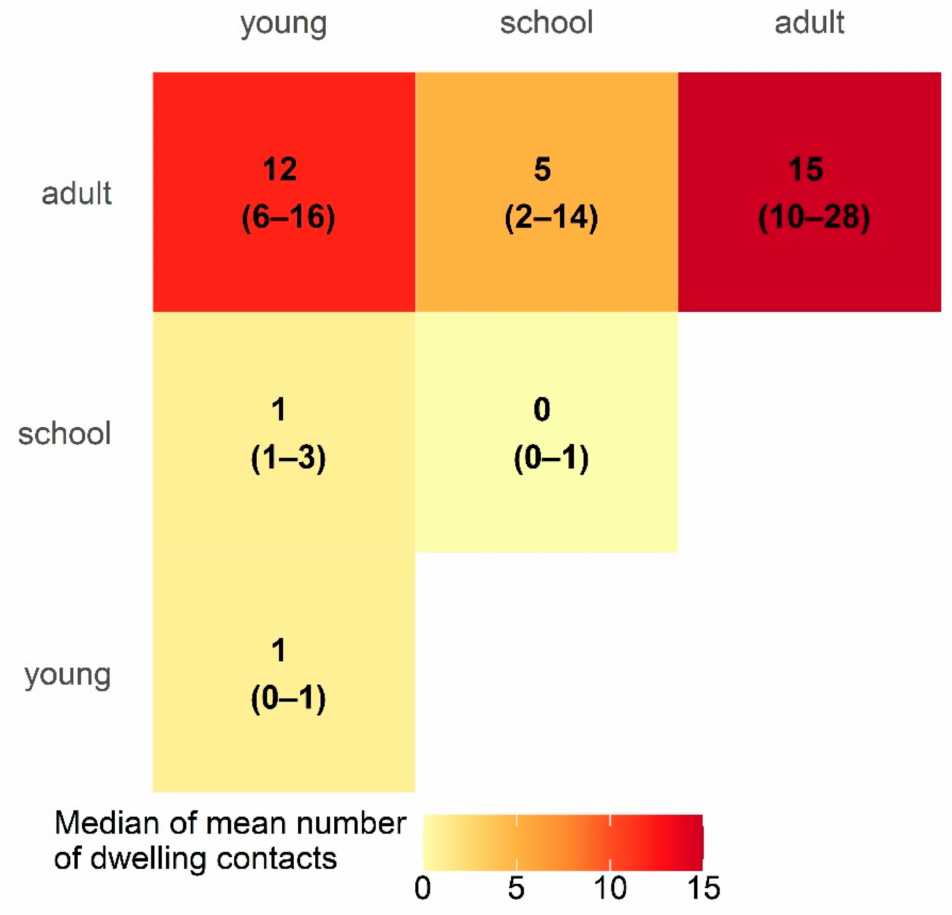
Figure 4. Median number of mean dwelling contacts between each age category per dwelling using the CAMP-remote data. Confidence intervals of 95%, estimated with a nonparametric bootstrap method, are indicated in brackets. Age ranges were young (less than 5 years), school-aged (5–14 years) and adult (15+